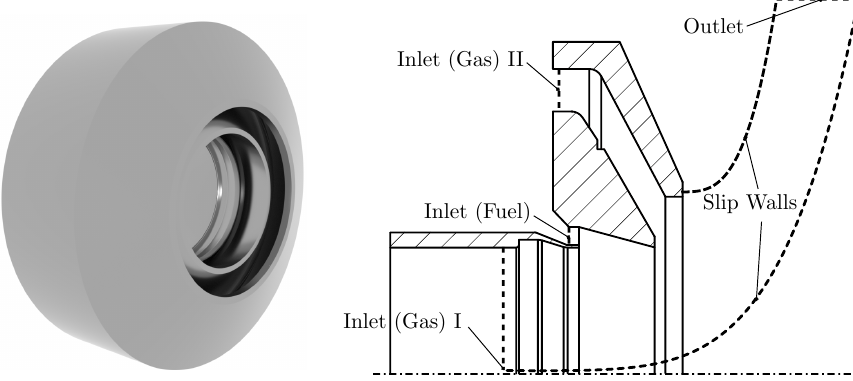
Figure 3. Nozzle geometry and computational